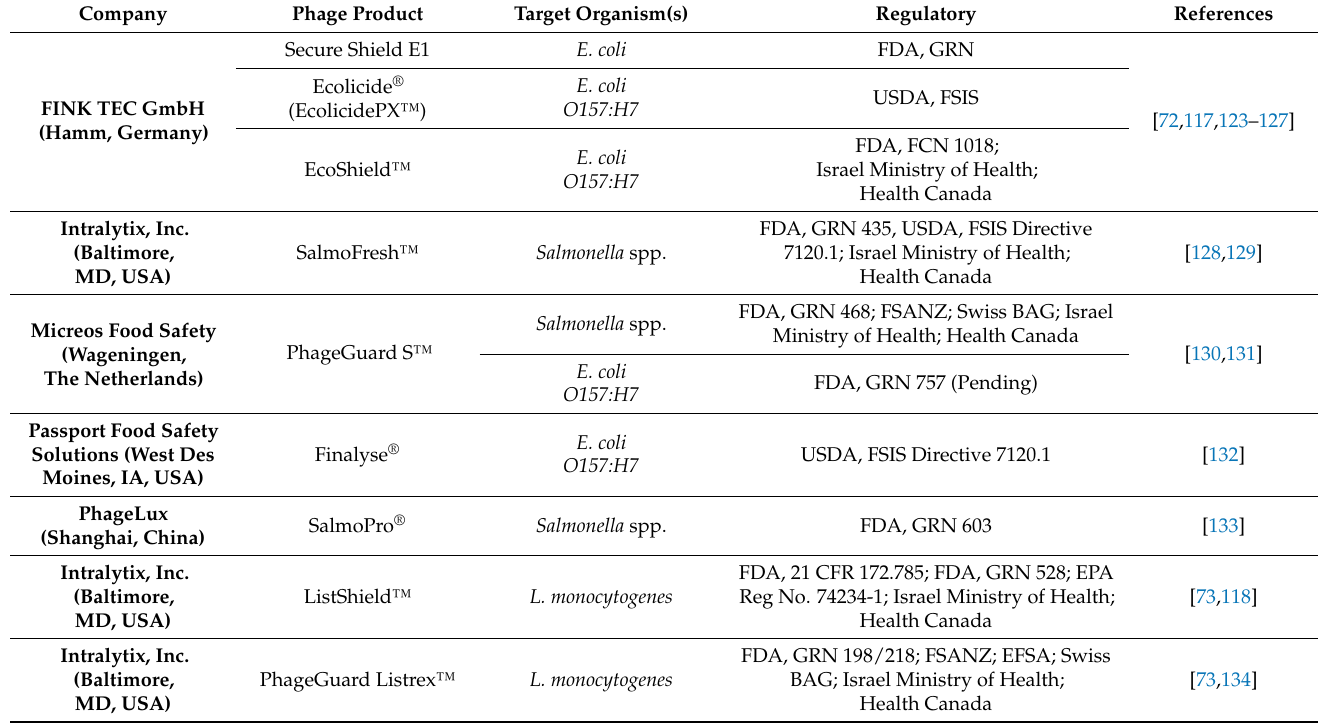
Table 4. Commercial Phage Biocontrol Products. Adapted and modified from Moye et al., 2018, A brief list of relevant commercial phage biocontrol